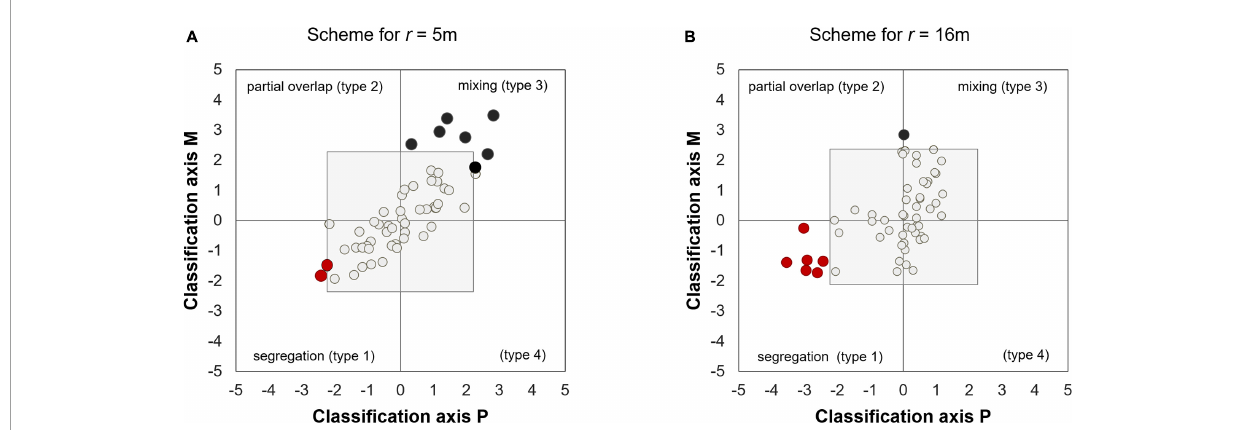
FIGURE3 Strength and direction of spatial association patterns among the 8 study species shown by the two dimensional classification scheme. (A,B) Shows the allocation of the 56 species pairs at small (5 m) and medium (16 m), respectively based on the P–M classification axes. Black and red solid circles represents species pairs showing mixing and segregation, respectively. The gray box indicates the area of independent placement. The scheme is spanned by the standardized effect sizes of the nearest neighbor distribution function D 12 (r) ( P -axis) and the K -function K 12 ( r ) ( M -axis).